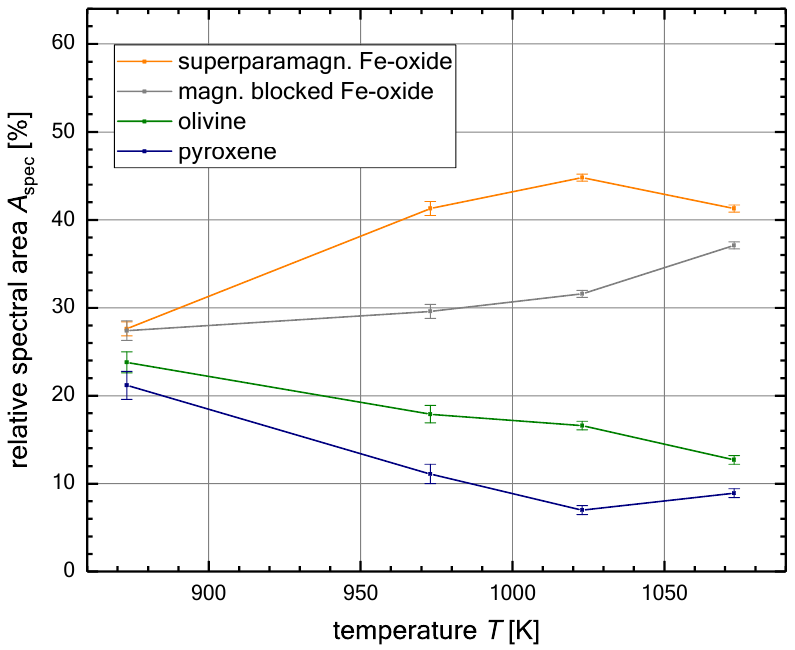
Figure 5. Changes in mineral content measured by Moessbauer spectroscopy for a basalt sample heated in air at different temperatures (from Demirci et al.